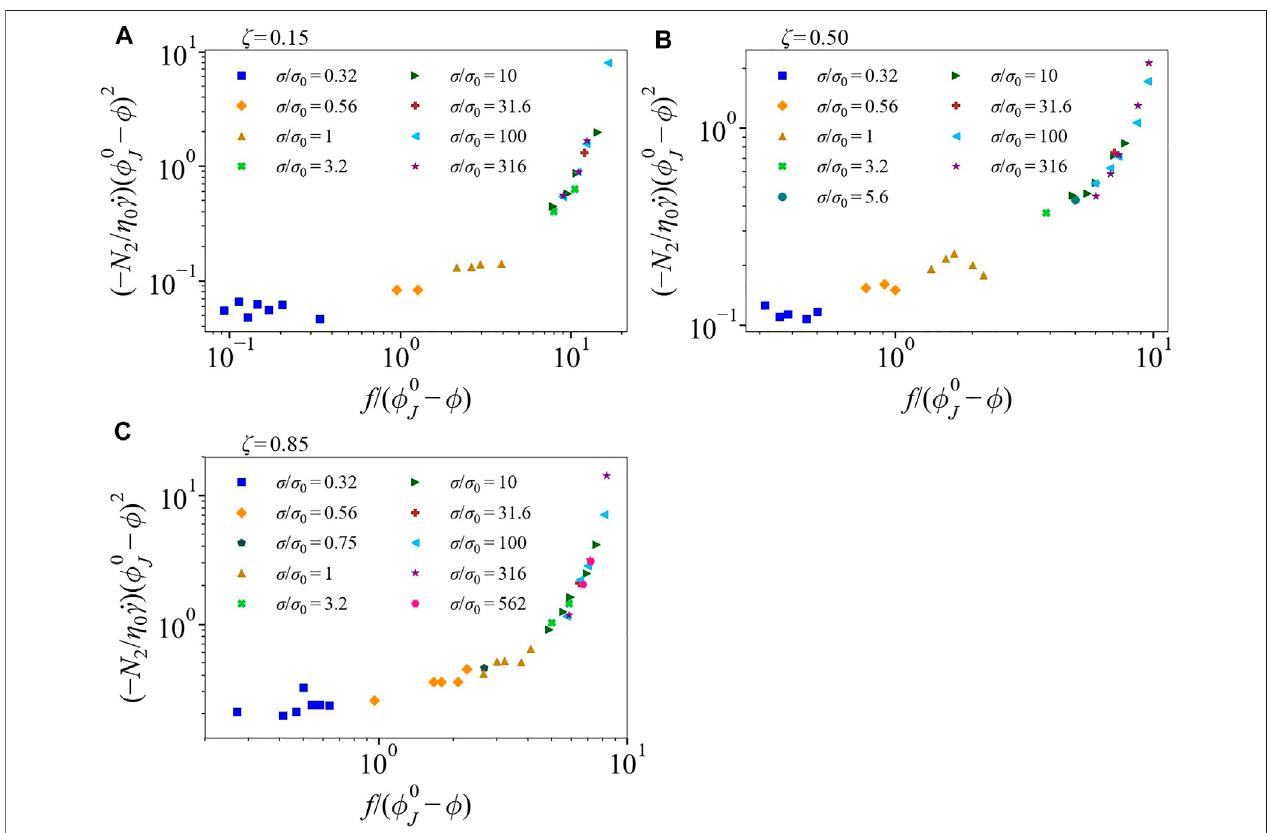
(cid:1) − ^ N ( ϕ 0 − ϕ ) 2 plotted asa function ofthe scaling variable x = f /( ϕ 2 J 2